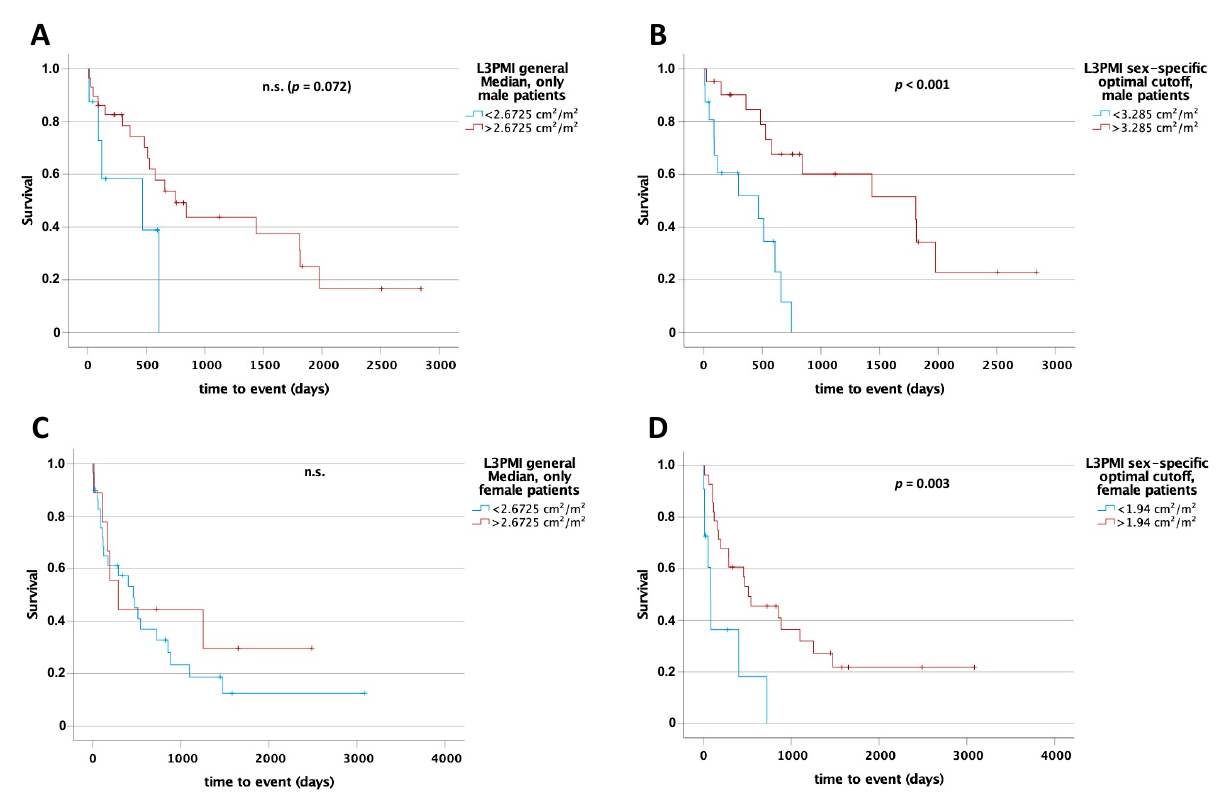
Figure 6. L3PMI is a sex-specific preoperative predictor for overall survival in patients undergoing surgery for CCA. Using the median (2.6725 cm 2 /m 2 ) for L3PMI of the total study cohort as a cut-off for overall survival in male ( A ) and female ( C ) subgroups, only in male patients could a clear trend for improved overall survival be identified. After using sex-specific cut-off values were statistically significant differences seen in both male and female patients ( B , D ). n.s. = not significant. Table 4. Univariate Cox regression analysis for the prediction of sex-specific postoperative overall survival.